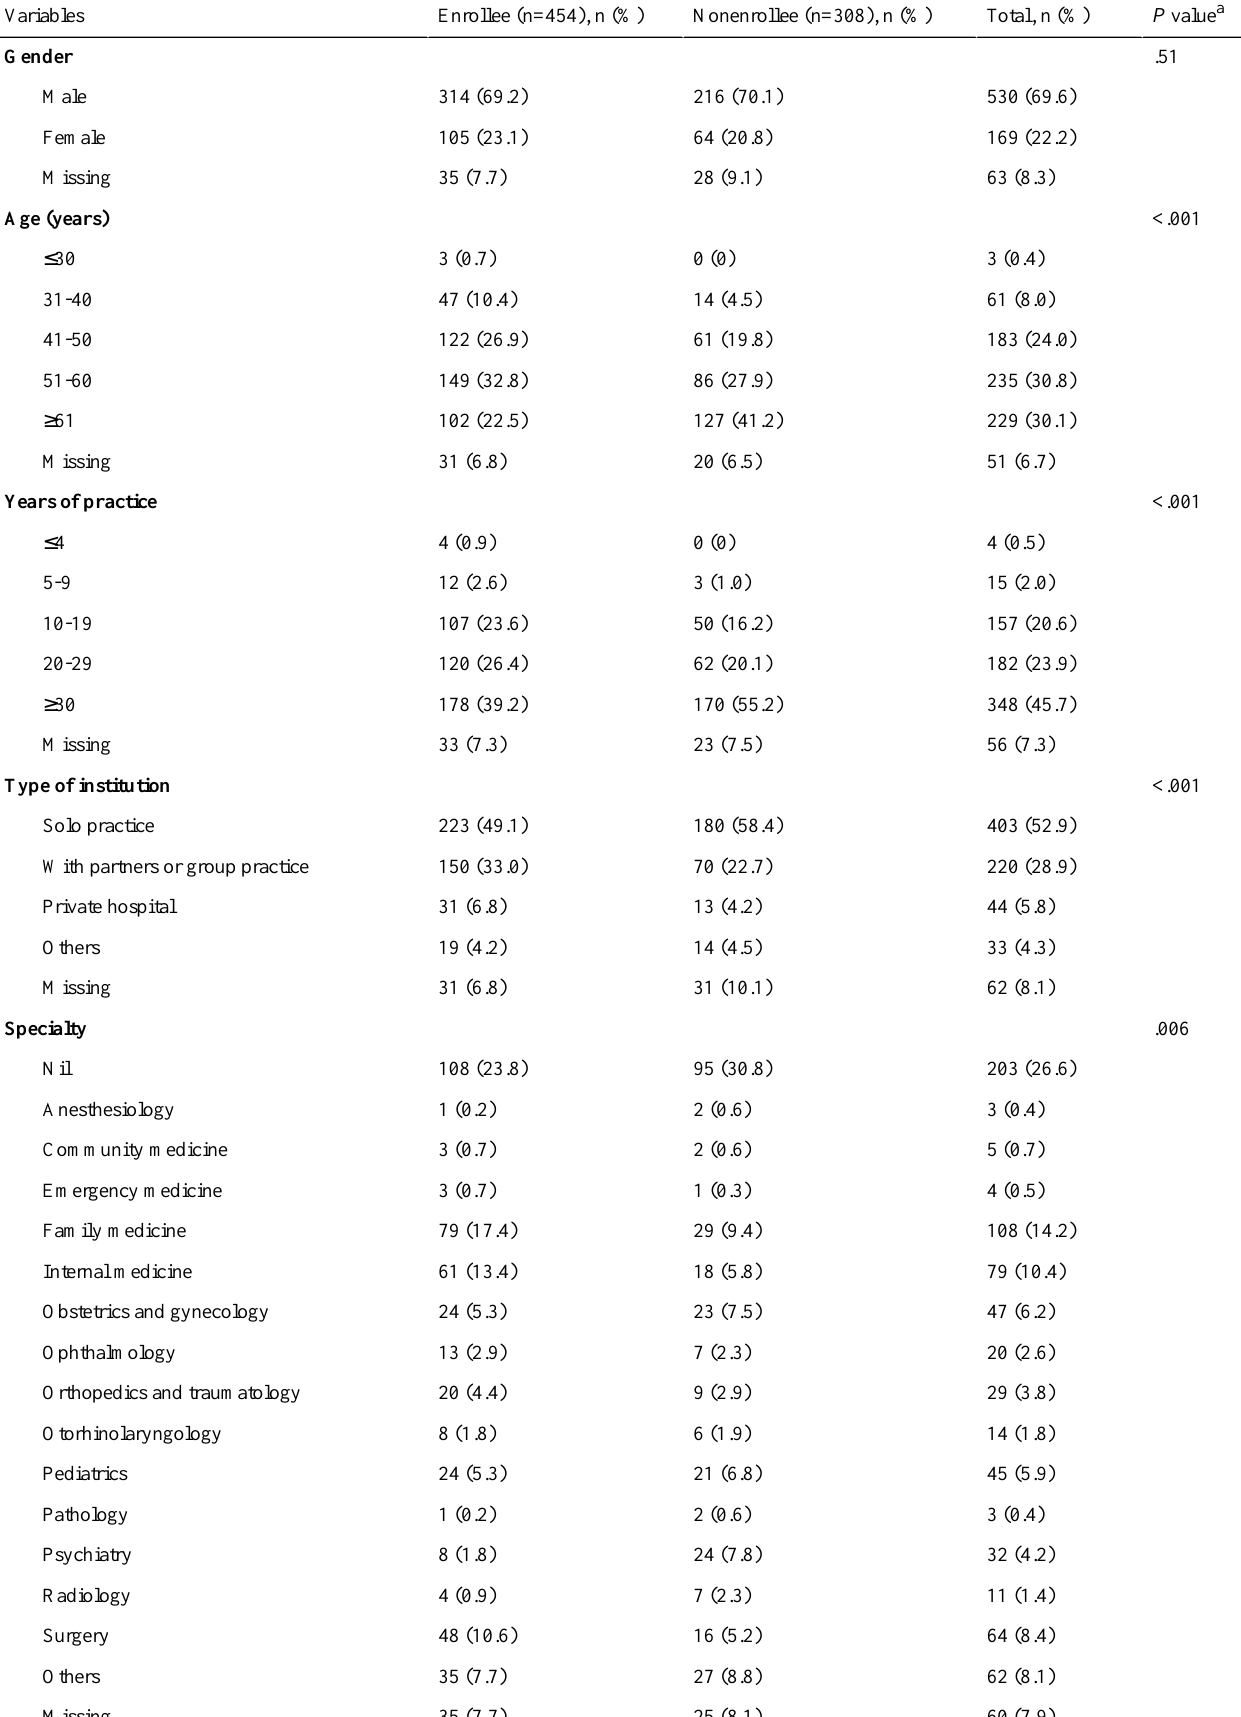
Table 3. Sociodemographic characteristics of physicians